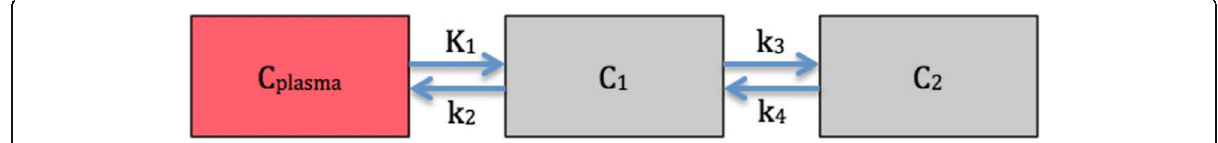
Fig. 1 Schematic representation of the three-compartment model applied for 18 F-FDG and 18 F-FLT. K 1 , k 2 , k 3 , and k 4 are rate constants (1/min) and describe the directional exchanges between the three compartments (c plasma represents the vascular compartment, c 1 represents the free and non-specifically bound compartment, and c 2 represents the trapped compartment). K 1 and k 2 are the inflow and outflow rate constants, respectively between the plasma and the free tracer compartment, and k 3 and k 4 are the rates of phosphorylation and dephosphorylation,